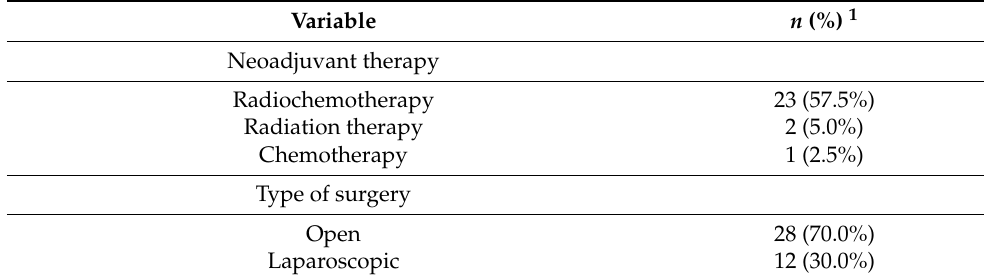
Table 1. Preoperative pretreatment and surgical